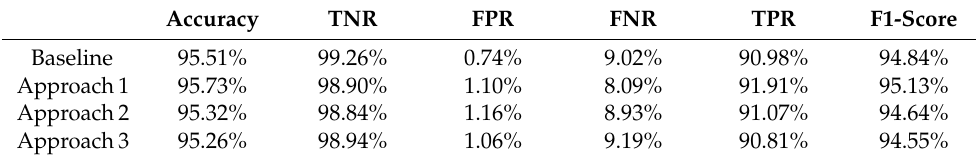
Figure 5. ROC curves for the baseline and the three approaches in the first test case. Table 7. Classification metrics for the baseline and the three approaches in the first test